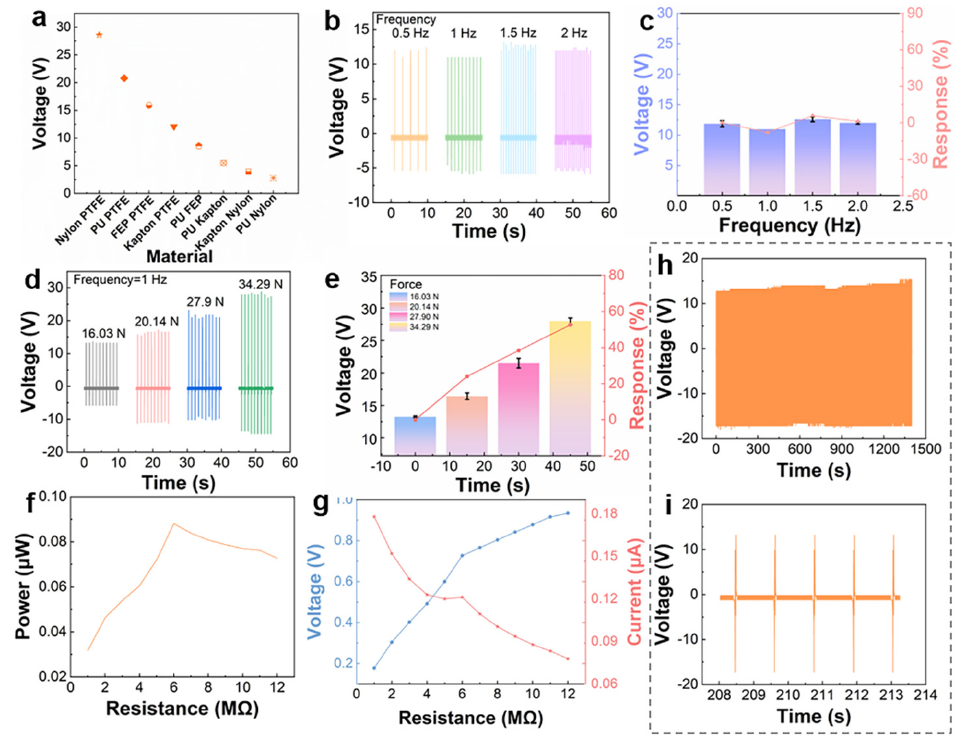
Figure 3. Output voltage performance of the LPS-TENG. ( a ) Output voltage combined with different materials. ( b ) Output voltage of the LPS-TENG at different frequencies. ( c ) Output voltage and response of the LPS-TENG at different frequencies. ( d ) Output voltage of the LPS-TENG at different forces. ( e ) Output voltage and response of the LPS-TENG at different forces. ( f ) Power of the LPS-TENG at different load resistances. ( g ) Output voltage and output current of the LPS-TENG at different load resistances. ( h ) Durability test of the LPS-TENG. ( i ) Endurance details.